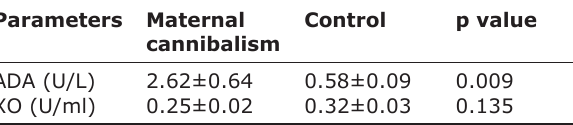
Table-1: Activities of ADA and XO between groups. Parameters Maternal cannibalism